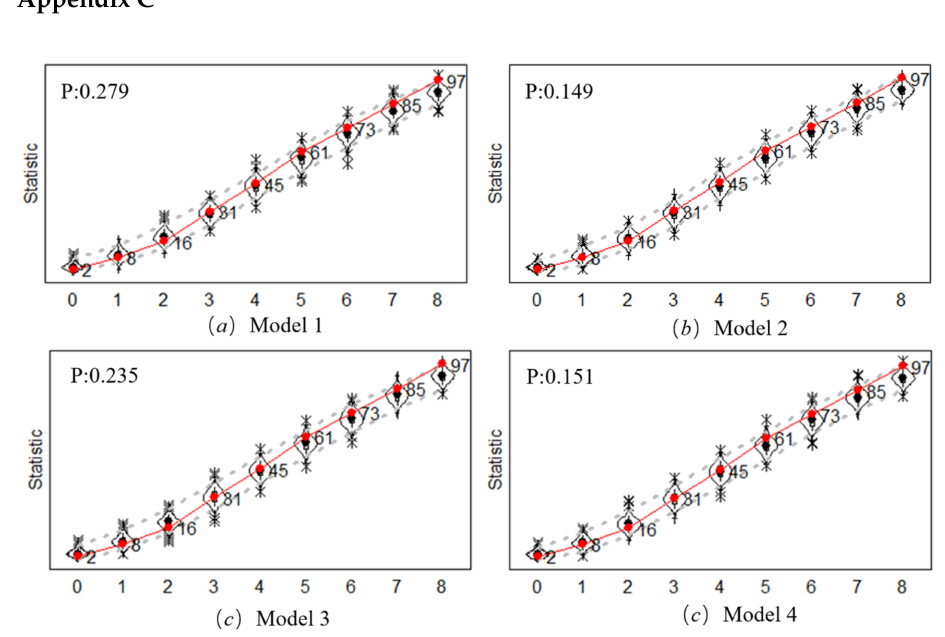
Figure A1. GOF test